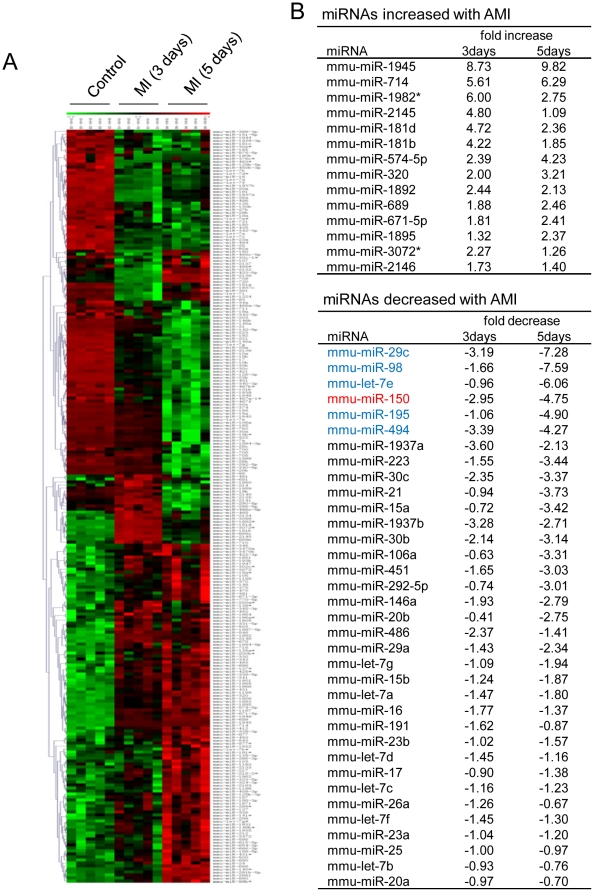
Microarray-based miRs expression profiling in BM-MNCs.(A) Gene tree represented on left and heat map on right of 15 experiments, respectively (n = 5). The color of the top bar shows the degree of expression (red; upregulated genes, green; downregulated genes). (B) The list of miRs whose expression was altered in BM-MNCs in response to LAD ligation.